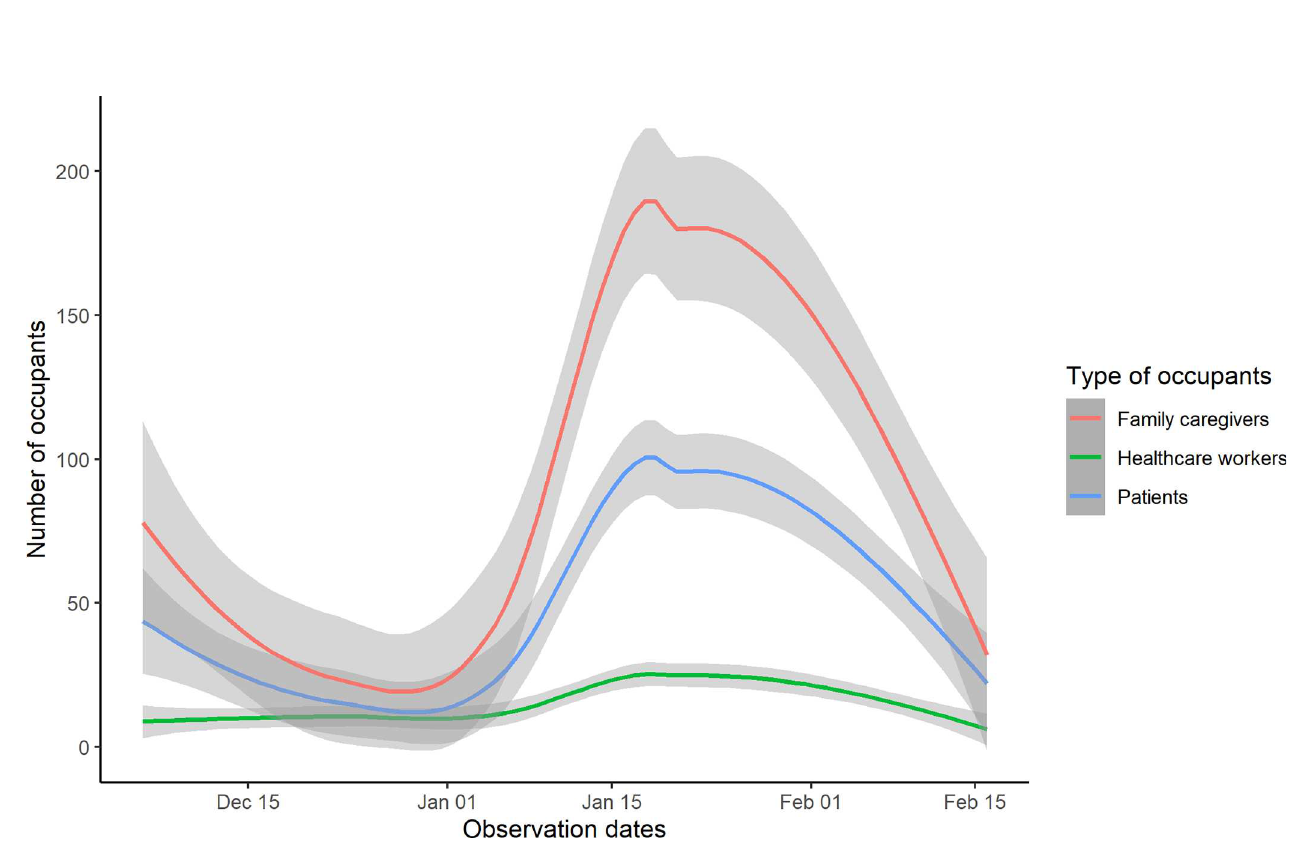
Fig 1. Distribution of patients, attendants and HCWs presence in medicine wards in two hospitals,